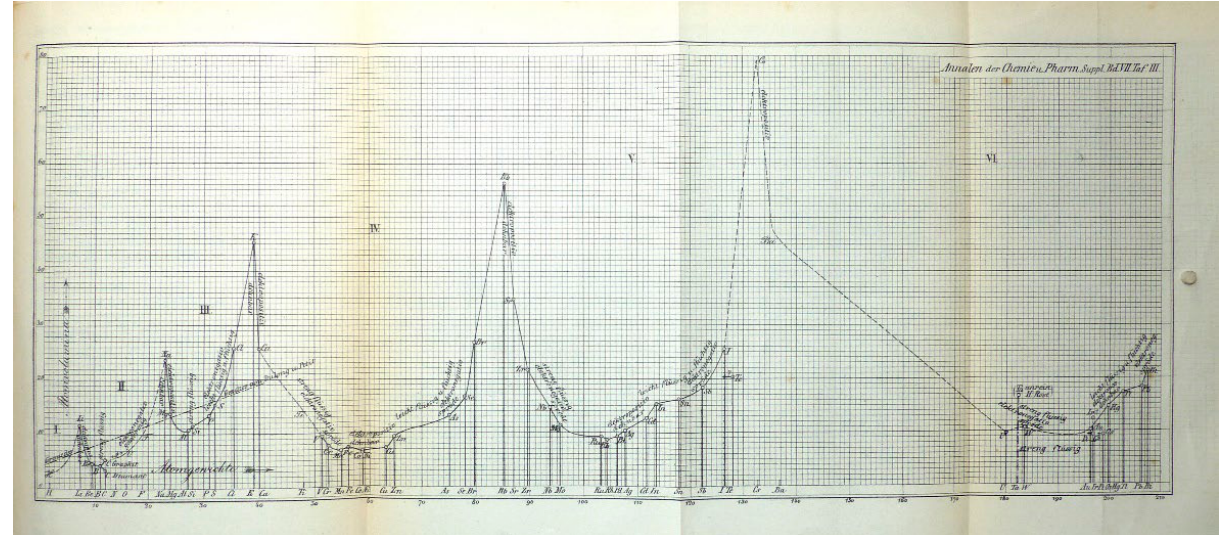
Figure 7. Presentation of the graph which shows the periodic relation between atomic volume and atom weight. Scan from L. Meyer, Annalen der Chemie und Pharmacie . VII. Supplementband 1871 , 354-364.